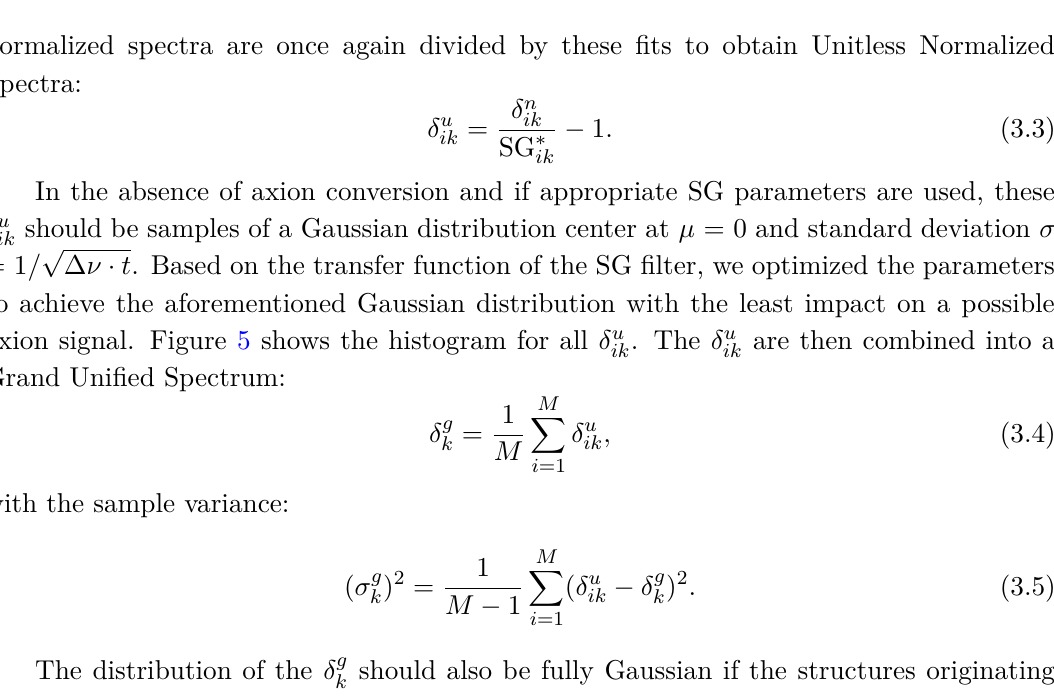
Figure 4 . Typical 90 s spectrum after the division procedure. The blue vertical lines indicate the data points and the red line the SG-fit.The plotted frequency range corresponds to the region delimited by the two vertical lines in the right panel of figure